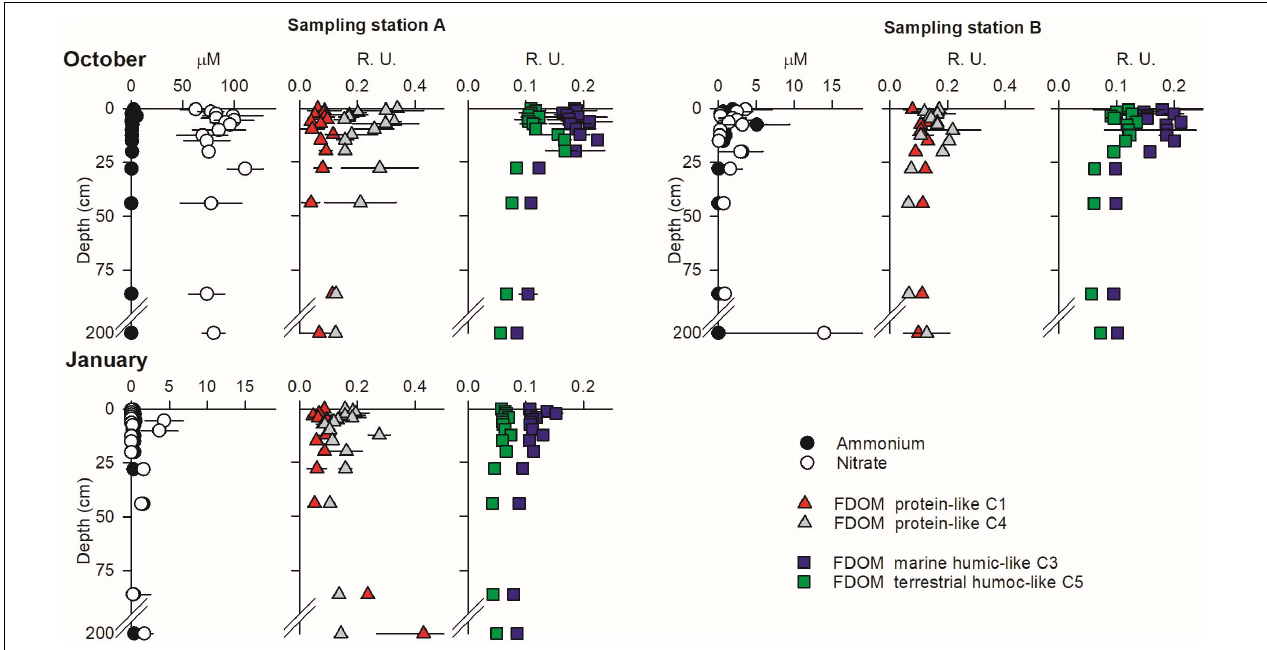
FIGURE 10 | High-resolution vertical porewater profiles of NH 4 + , NO 3 − , and FDOM components during the peak of discharge in stations A and B during October 2010 and January 2011 (only station A). Porewater profiles correspond to the average of those obtained during two consecutive tidal cycles with piezometers and porewater profilers. Note the different scale used in the NO 3 − and NH 4 +